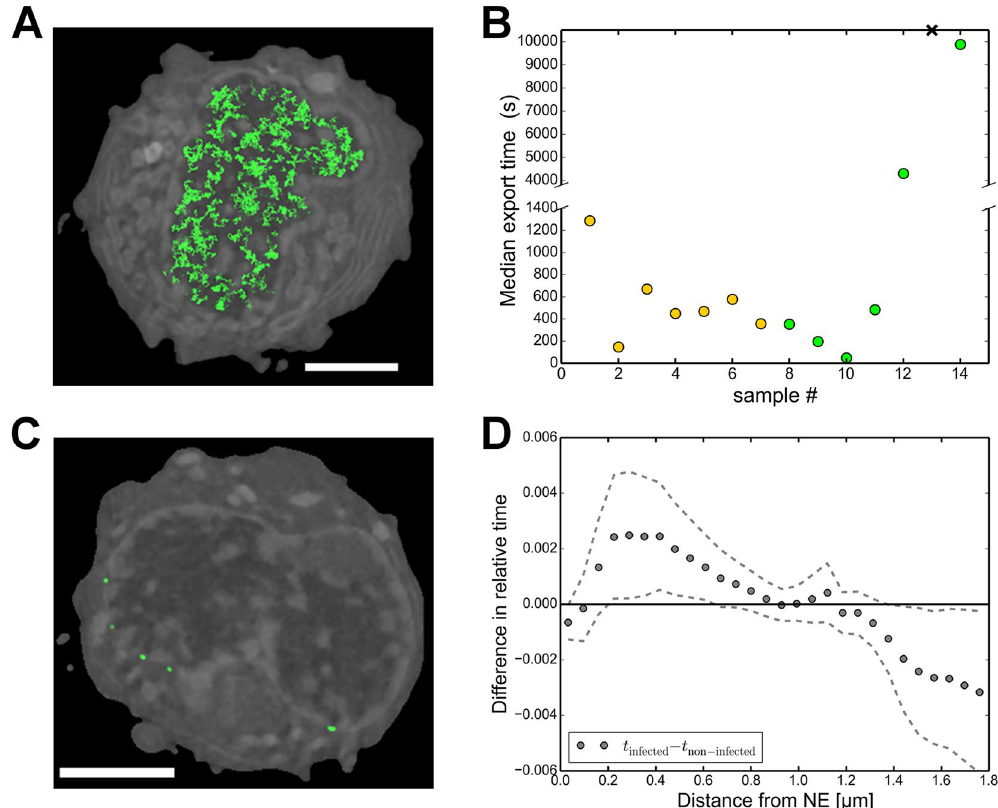
Figure 5. Nuclear transport of capsids to the NE. ( A ) Paths traced by 1000 capsids for 5 seconds (green) near one plane of the simulation geometry. The displayed path has a lower intensity when it is farther away from the SXT orthoslice shown as background (grey). Low and high LAC values of chromatin are indicated with dark and light greyscale values. Scale bar, 3 μ m. See also Supplementary Movie S2. ( B ) Median transport times of capsids to the NE for infected (yellow) and non-infected (green) cells. The control cell with a cross symbol did not allow passage of capsids, and the median time is therefore not defined for it. The break in the y -axis separates low and high transport times. ( C ) Low-density nuclear egress sites of capsids (green) in an SXT cross- section of an infected cell. Scale bar, 3 μ m. See also Supplementary Movie S3. ( D ) Difference in the relative amount of time spent by capsids at various distances from the NE between the infected and non-infected cells. Dotted error lines represent the mean ±